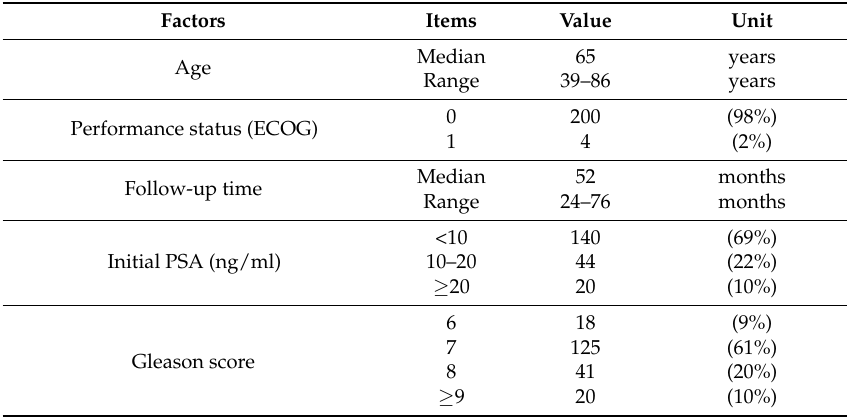
Table 1. Patient